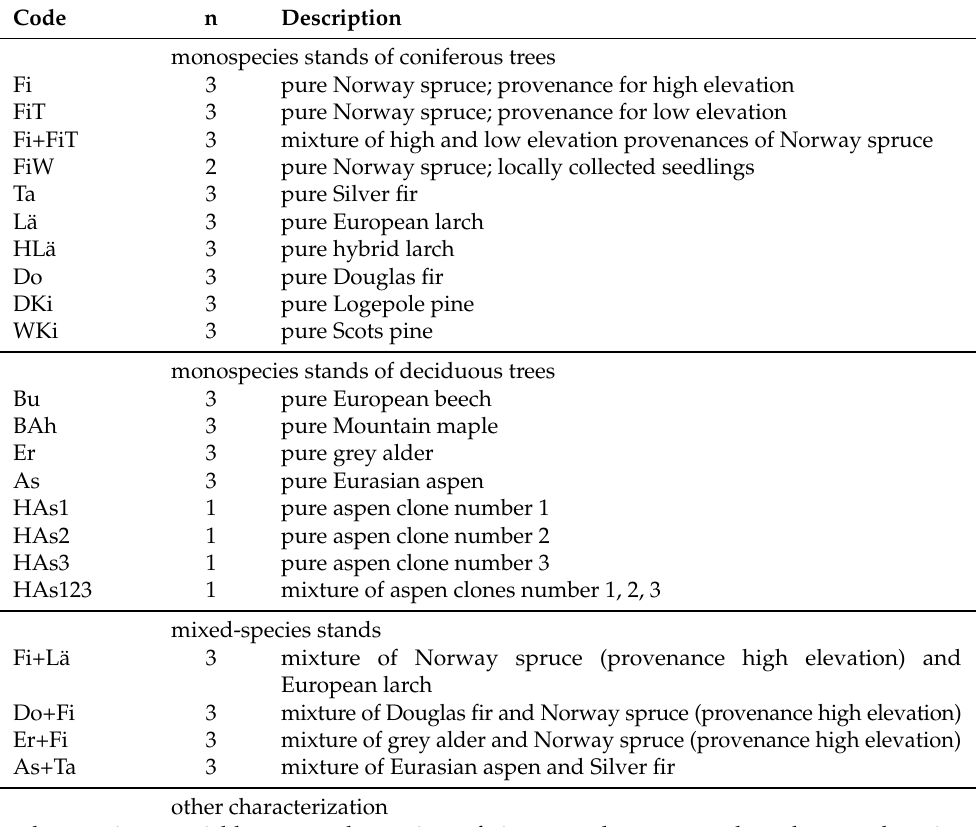
Table 4. Treatments in the reforestation experiment, Wechsel. ‘n’ denotes the number of replications.